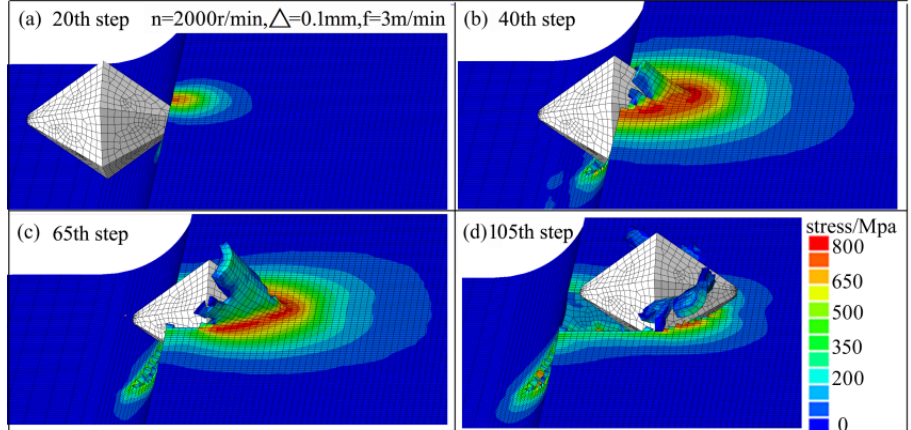
Figure 7. Stress field and chip formation in abrasive impact process: ( a ) 20th time step; ( b ) 40th time step; ( c ) 65th time step; ( d ) 105th time step.